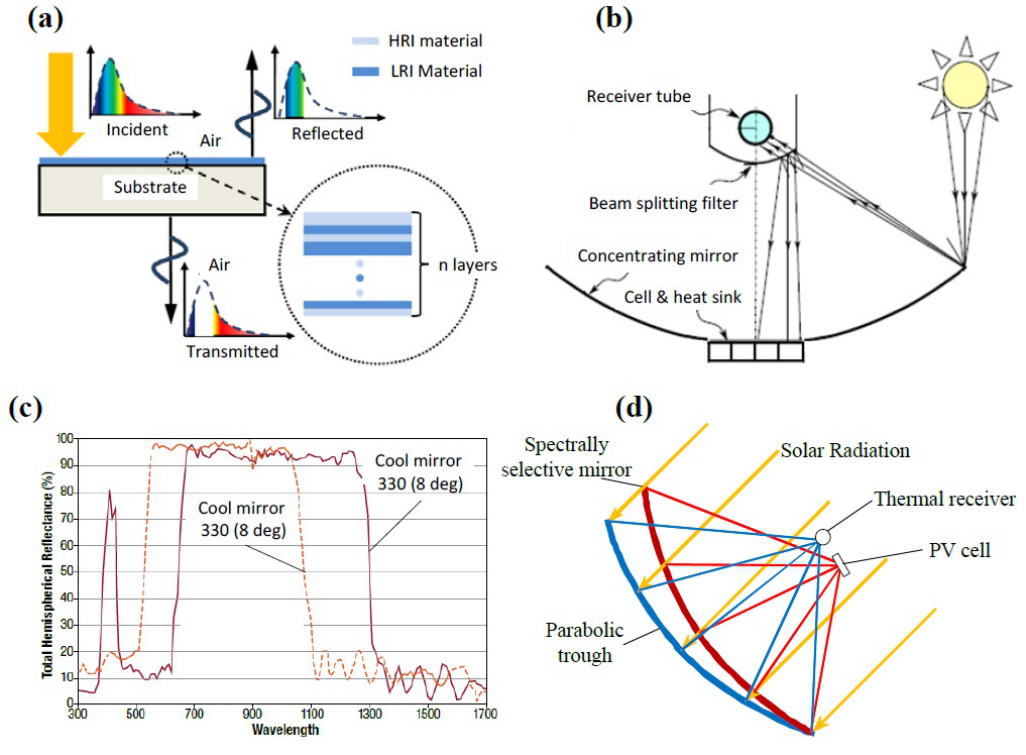
Figure 2: Schematic of thin film dichroic mirrors made of n layers [3]. (b) Implementing dichroic mirrors close to the focal region of solar concentrators under concentrated light [25]. (c) The spectral reflectance of commercially available 3M cool mirror film designed for Si PV cells at 8 ∘ and 60 ∘ angle of incidence [22]. (d) Spectrally splitting hybrid PVT configuration using polymer reflective films based on the design introduced by Vincenzi et al.